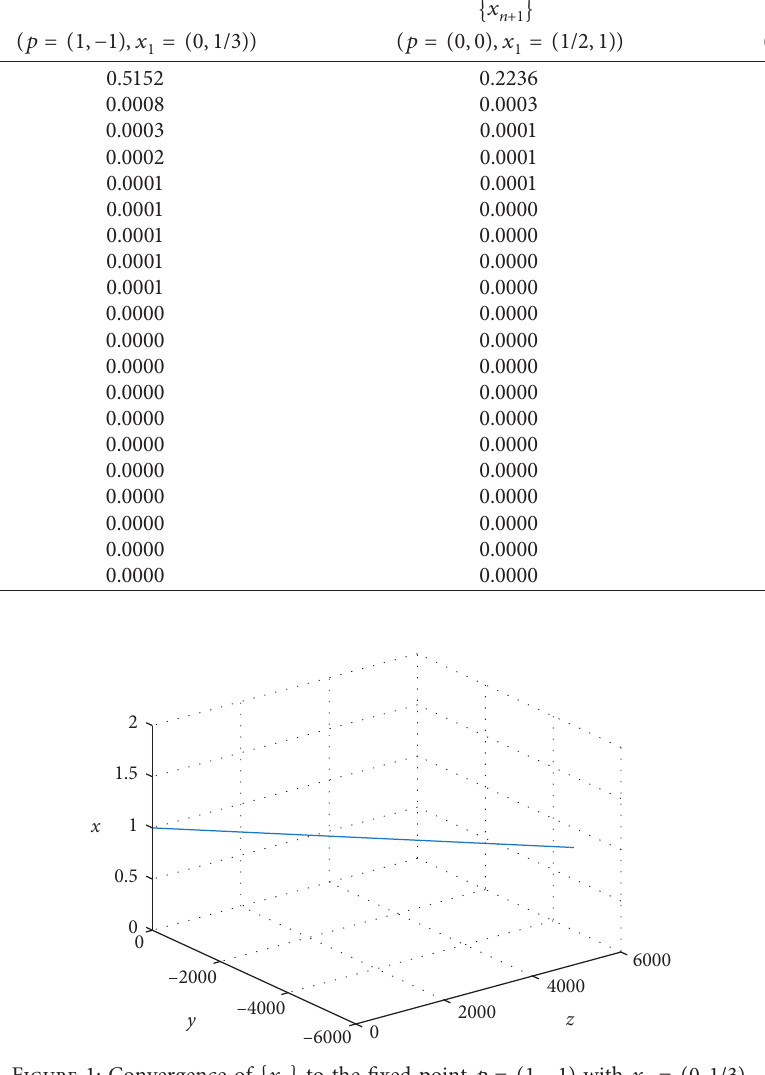
􏼈 􏼉 to the fixed point p � ( 1 , − 1 ) with x n